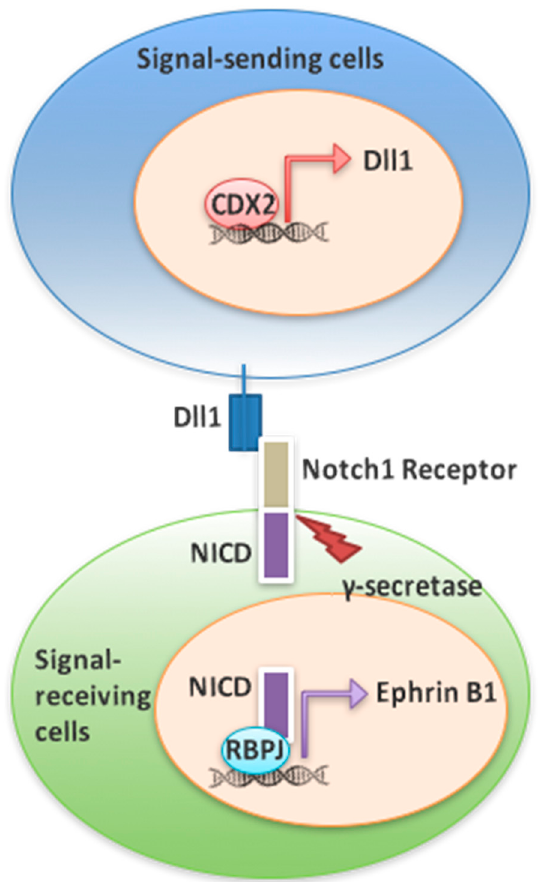
Figure 7. Model for Cdx2-dependent regulation of impact of EphrinB1 expression. Cdx2 binds to the promoter of Dll1 to effect Notch activation on an adjacent cell. Activation of the Notch receptor leads to cleavage of the NICD by γ -secretase and transcription of EphrinB1 .